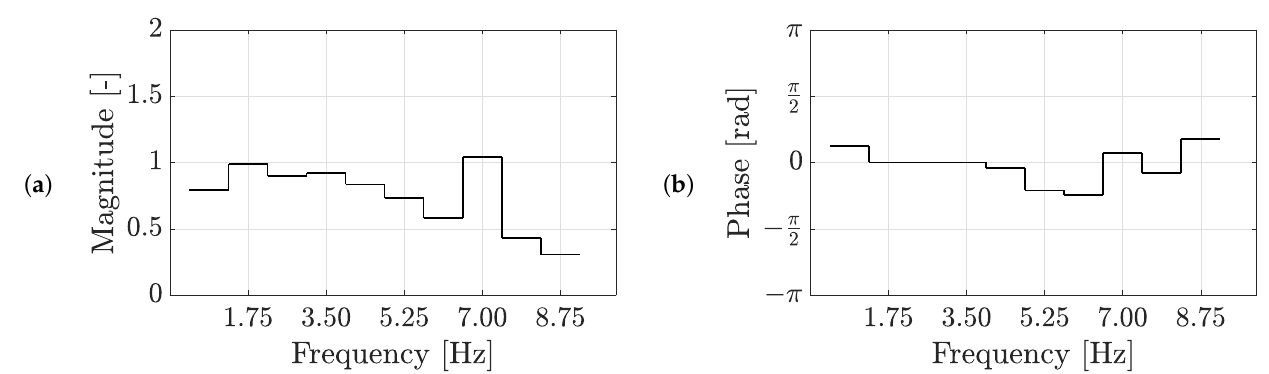
Figure 6. Estimated transfer function for the reference trial: ( a ) magnitude and ( b ) phase angle.